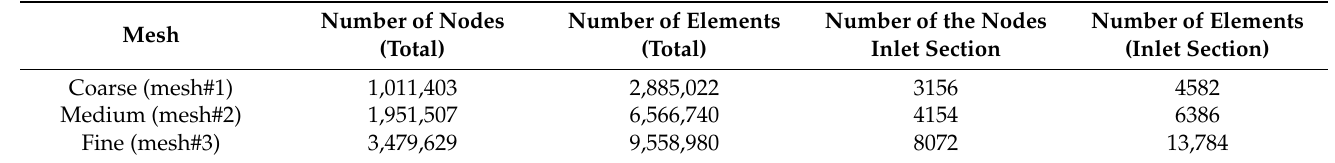
Table 2. Different mesh configurations are used for the mesh sensitivity test.